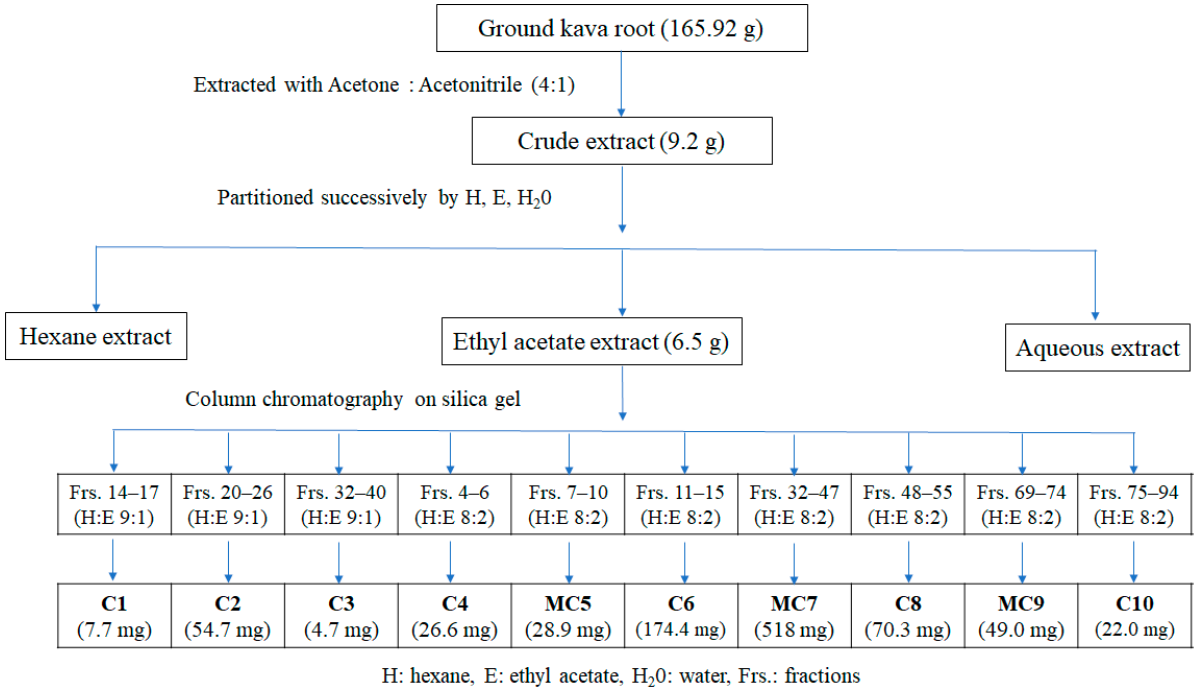
Figure 1. Fractionation and column chromatography separation of kava root.